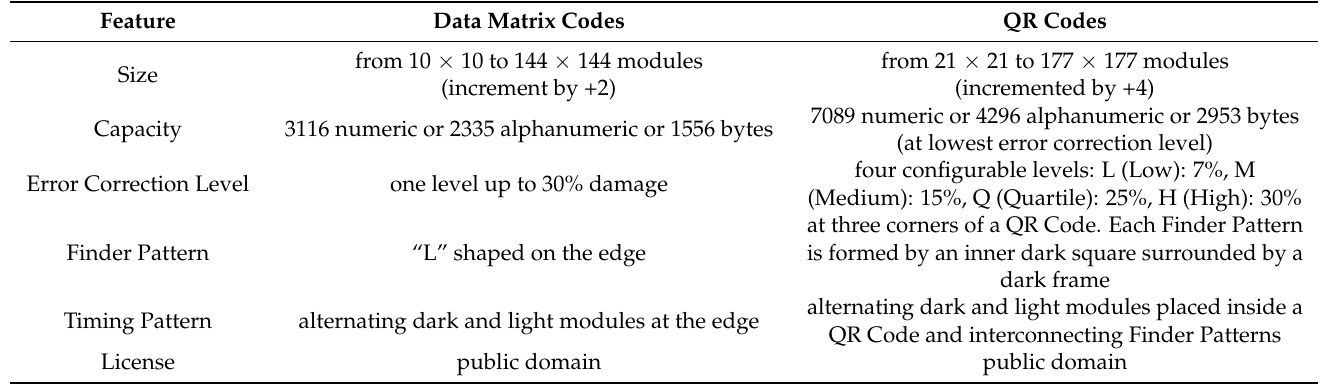
Table 1. Comparison of Data Matrix codes and QR